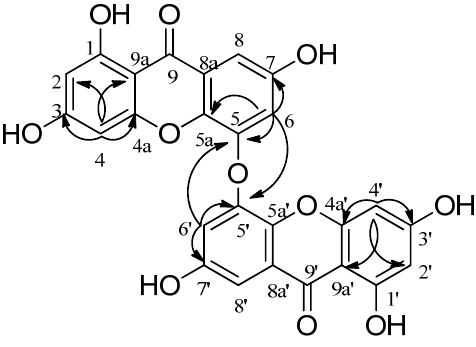
Figure 2. Selected HMBC correlations for 1 . Table 1. NMR data of compound 1 and gentisein acetone- d 6